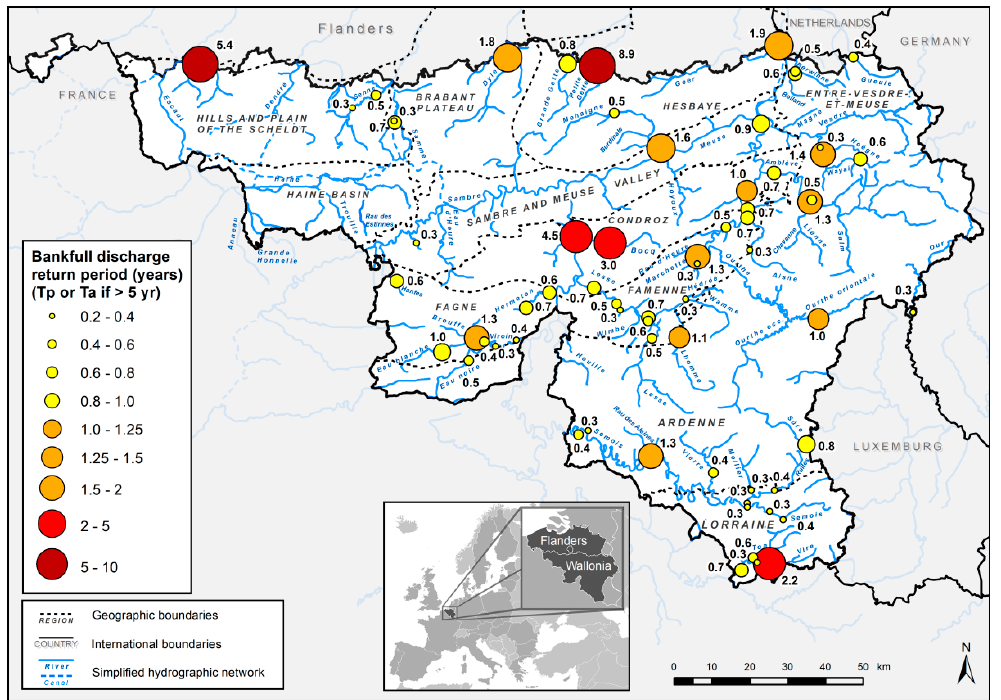
Figure 5. Return period of the observed bankfull discharge (expressed in partial series for values below 5 years and in annual series beyond).